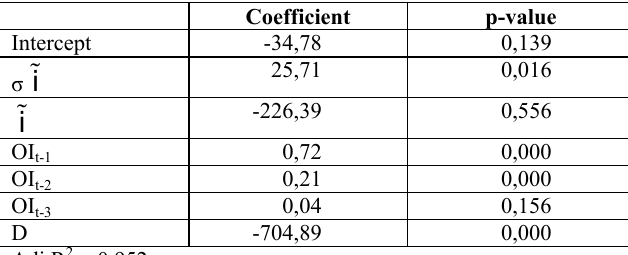
Table 9: Regression summary of volatility on open interest – FINI